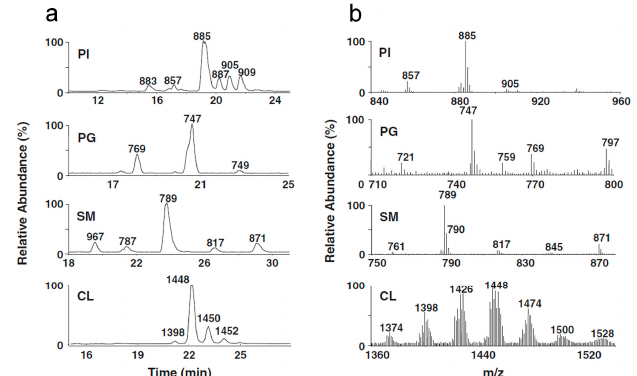
Figure 12. Second dimension (2D) separation of rat brain phospholipids by reverse-phase HPLC-MS/MS. Individual fractions corresponding to PI, PG, SM and CL from the 1D analysis were pooled based on phospholipid class and re-chromatographed in the 2D C18 reverse-phase system. Lipids were identified based on retention time and MS/MS analysis. The following rat brain phospholipid classes which eluted as essentially single peaks in the 1D system, were resolved into the following number of peaks in the second dimension: (PI, 6), (PG, 3), (SM, 5) and (CL, 4). ( a ) Chromatograms for PI, PG and SM. The chromatogram for CL was collected in full MS mode. Summed spectra across all peaks for each phospholipid class are shown in ( b ). Reproduced with permission from [60]. Copyright Elsevier, 2012.